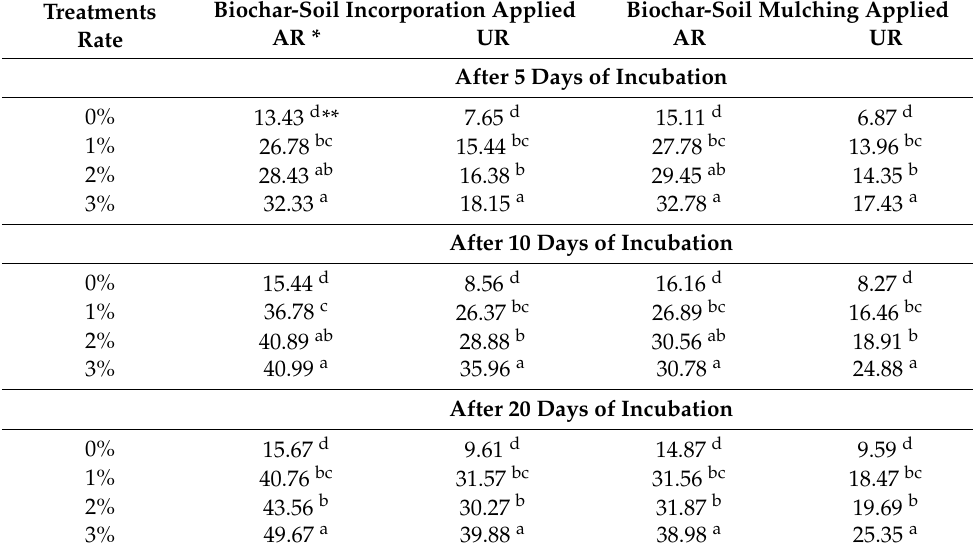
Table 12. Effect of irrigation with Al-Moheet drainage water on the activity of arginase (AR) and urease (UR) in sandy soil amended with corncob biochar.